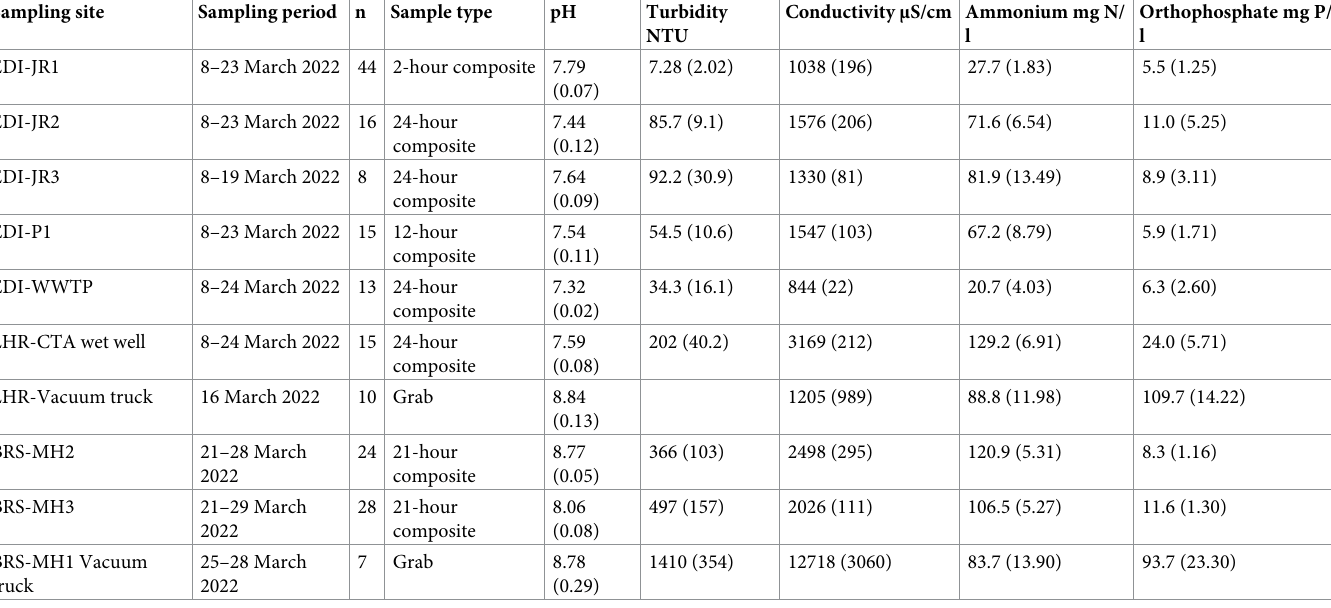
Table 2. Sampling sites, sample types, numbers, and physico-chemical properties for wastewater collected at three UK airports. Sampling